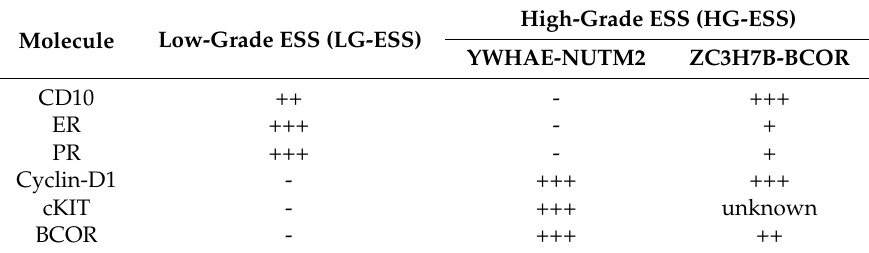
Table 1. Immunohistochemical profiles of endometrial stromal sarcoma (ESS)